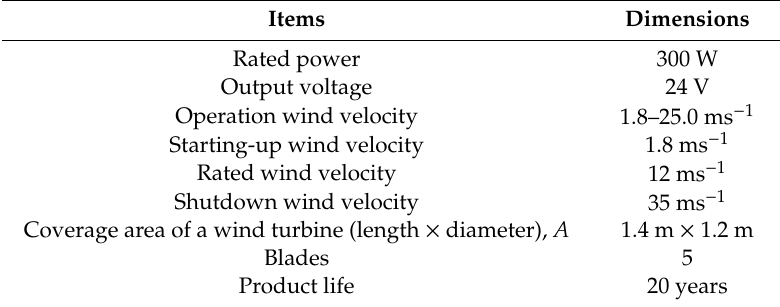
Table 2. Specific parameters of the wind turbine [53].